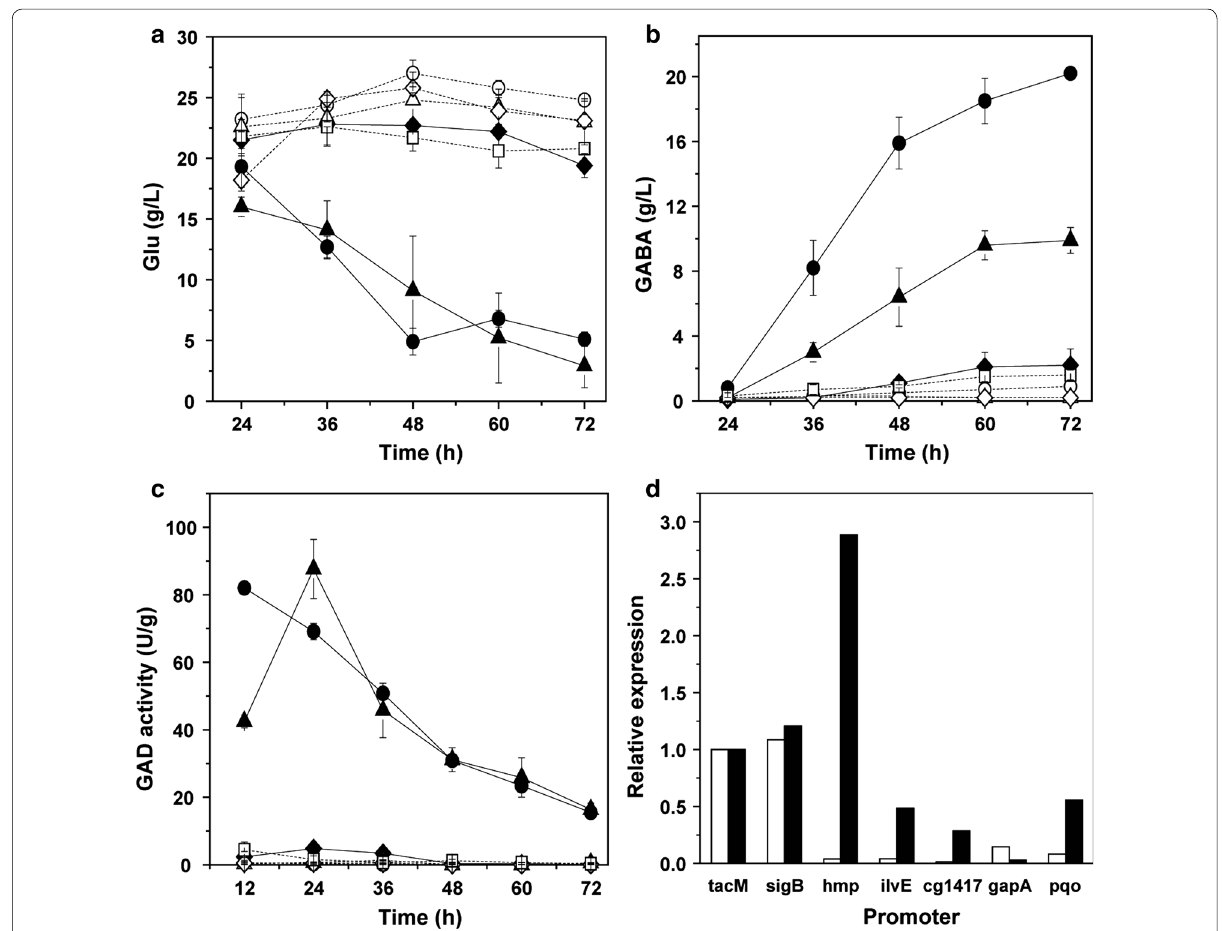
Fig. 4 GABA fermentation of gadB2 -expressing C. glutamicum strains controlled by sigB promoter and some σ B -recognized promoters. a Glu con- centration, b GABA concentration, c GAD activity, d gadB2 transcription level. Circles R4a-B2, triangles P sigB -B2, diamonds P hmp -B2, empty squares in dotted line P pqo -B2, empty circles in dotted line P ilvE -B2, empty diamonds in dotted line P gapA -B2, empty triangles in dotted line P cg1417 -B2. White bars at 20 h, black bars at 40 h. Each point represents the average of three independent